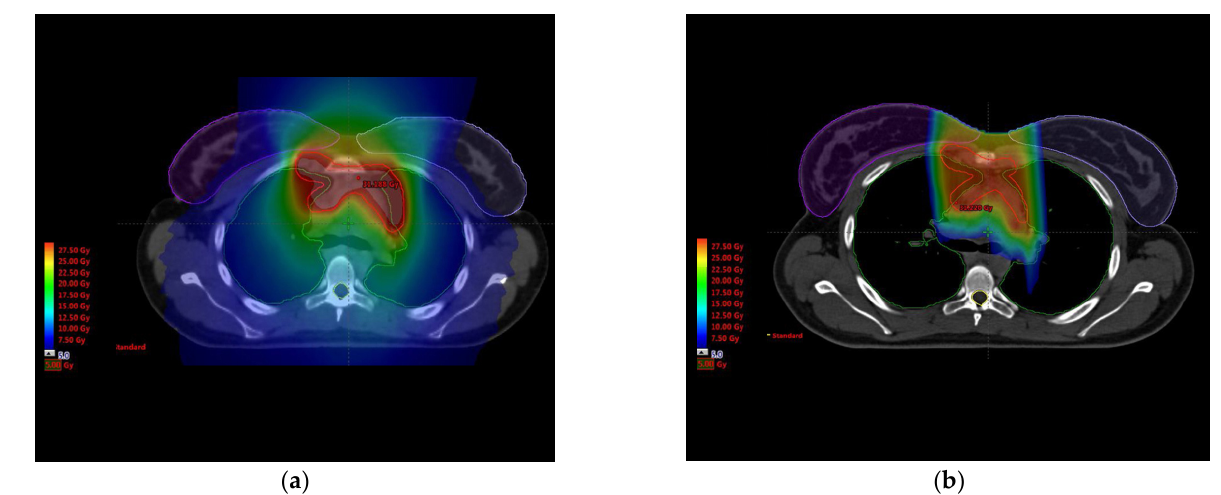
Figure 1. Example of organ-at-risk (OAR) sparing with proton therapy for Hodgkin lymphoma. This 24-year-old patient had to be treated to the dose of 30.6 Gy to the PTV (red), partly localized in the inferior anterior mediastinum, under the origin of the left main coronary artery. A comparative dosimetry was realized between DIBH-VMAT plan ( a ) and proton therapy ( b ). Proton therapy reduced radiation exposure to the breasts (delineated in purple), to the lungs (delineated in green), to the heart and to the esophagus, compared with VMAT; this may translate into fewer OAR late toxicities (and potentially fewer secondary cancers). In particular, the mean heart dose was reduced from 3.7 Gy with VMAT to 2.6 Gy with proton therapy, which might reduce late radiation-induced cardiotoxicity. This patient was finally treated using DIBH involved site proton therapy.